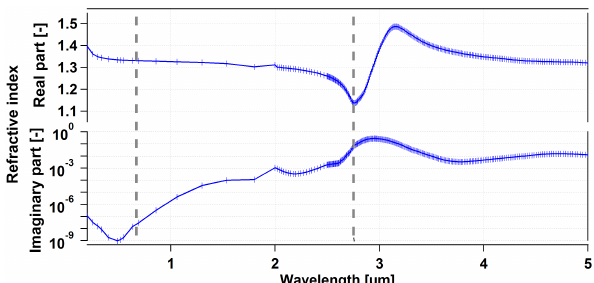
Figure 1. Real and imaginary part of the refractive index of water as a function of wavelength (Rothman et al., 2013); the dashed grey lines show our two selected wavelengths of 660 and